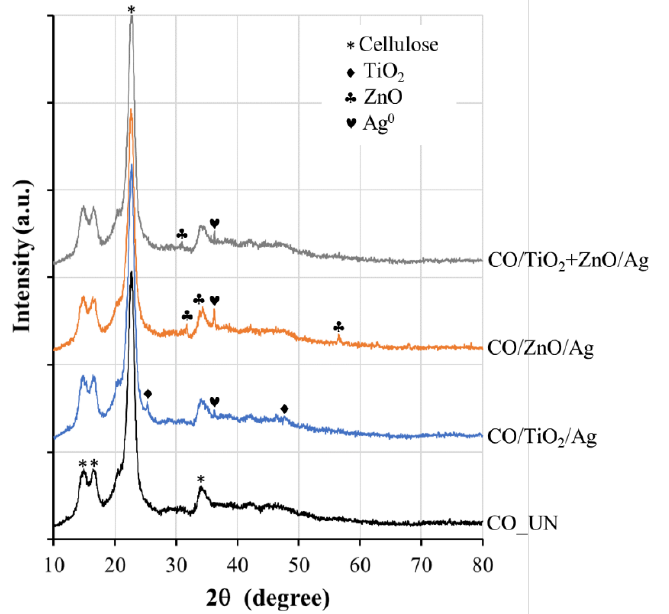
Figure 3. XRD patterns of untreated (CO_UN) and chemically modified CO/TiO 2 /Ag, CO/ZnO/Ag and CO/TiO 2 + ZnO/Ag samples.